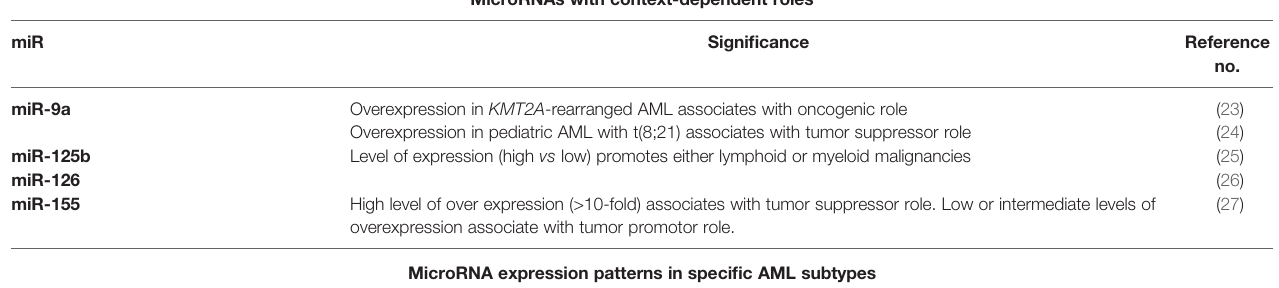
MicroRNAs with context-dependent